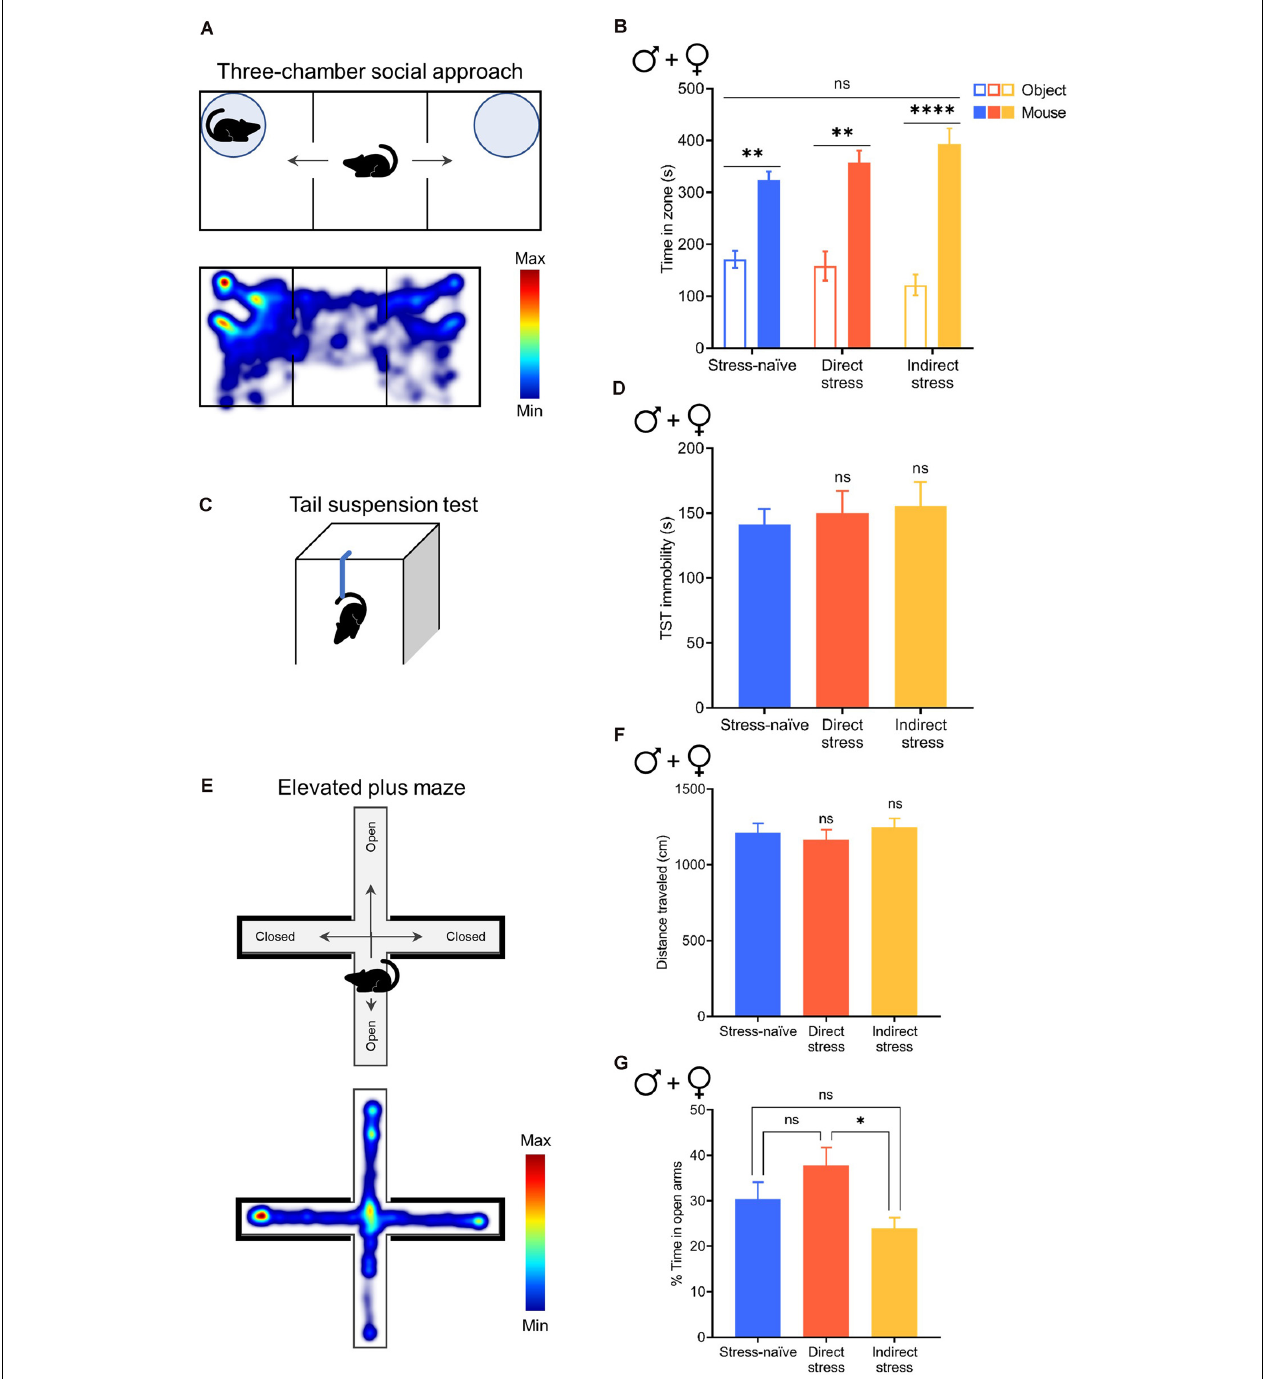
FIGURE 5 | Direct and indirect stress do not affect social interaction, depression-like behavior, or anxiety-like behavior 1week after stress exposure. (A) Cartoon depicting the three-chamber social approach assay (top) and a representative heatmap of activity during this test (bottom). (B) Time spent in the novel object and novel mouse zones in the three-chamber social approach assay in stress-naïve ( n = 8), directly stressed ( n = 6), and indirectly stressed ( n = 7) males and females. (C) Cartoon depicting the tail suspension test (TST). (D) Time spent immobile for the 6-min duration the TST in stress-naïve ( n = 10), directly stressed ( n = 11), and indirectly stressed ( n = 10) males and females. (E) Cartoon depicting the elevated plus maze (EPM, top) and a representative heatmap of activity in the EPM (bottom). (F) Distance traveled in the EPM in stress-naïve ( n = 32), directly stressed ( n = 25), and indirectly stressed ( n = 29) males and females. (G) Percent of total time spent exploring the open arms of the EPM in stress-naïve ( n = 32), directly stressed ( n = 25), and indirectly stressed ( n = 29) males and females. Error bars, SEM. ns: P > 0.05, ∗ P < 0.05, ∗∗ P < 0.01, ∗∗∗∗ P < 0.0001.